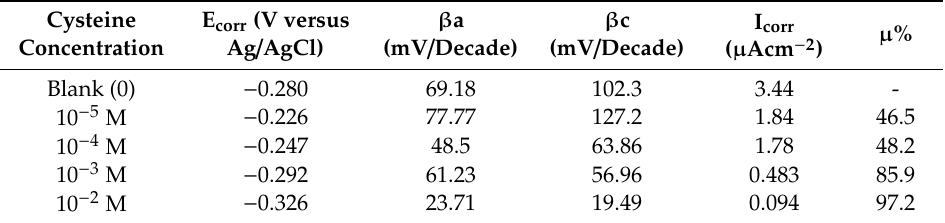
Table 1. Polarization parameters for the Cu5Zn5Al1Sn alloy measured in 3.5 wt.% NaCl solution in the absence and presence of di ff erent concentrations of